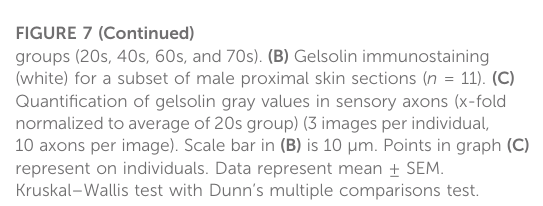
FIGURE 7 Association of differentially expressed cytoskeletal genes withtheactincytoskeleton. (A) Normalizedrow-scaledexpression of transcriptomic data fi ltered for differentially expressed cytoskeletal genes associated with the actin cytoskeleton as identi fi ed by GO analysis (Figures 6B – C) between the four age